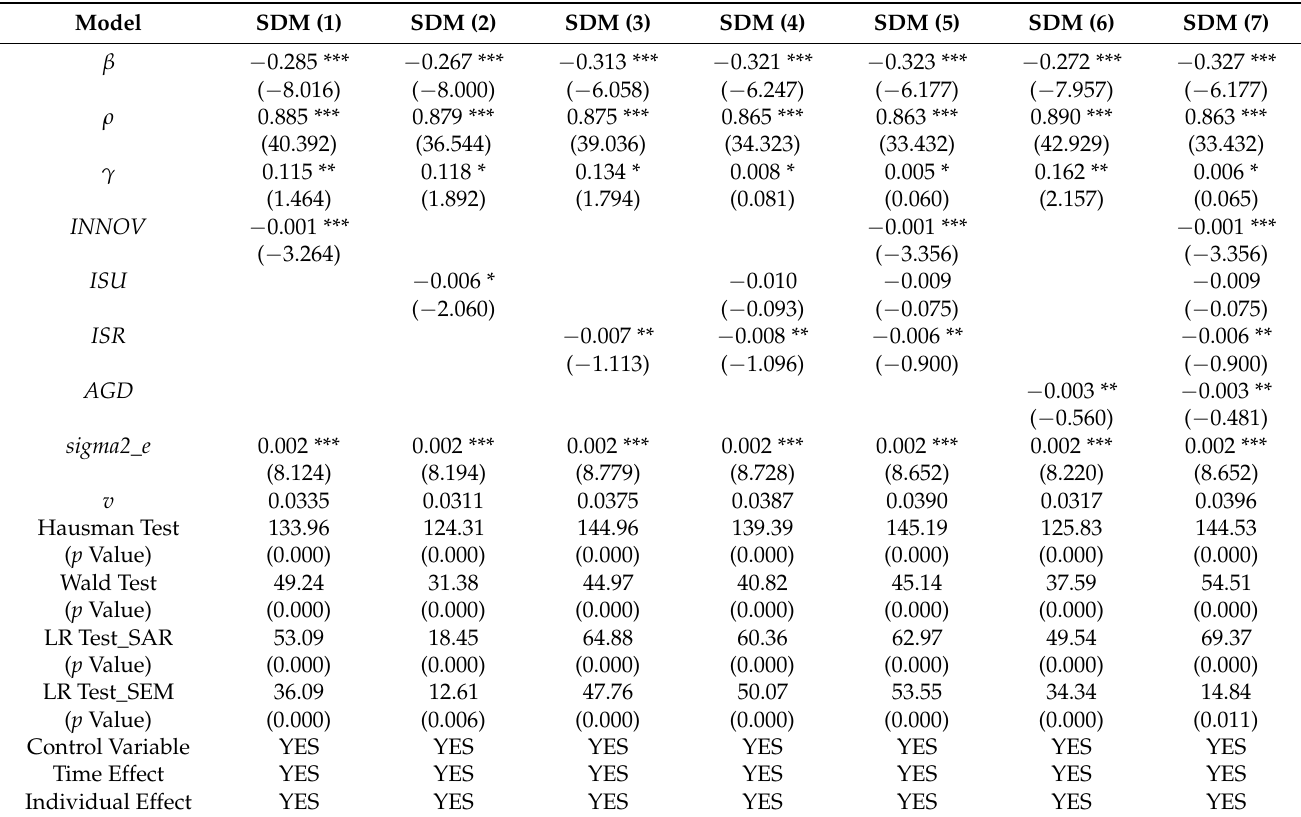
Table 6. Conditional β convergence characteristics of CEI of all cities in the